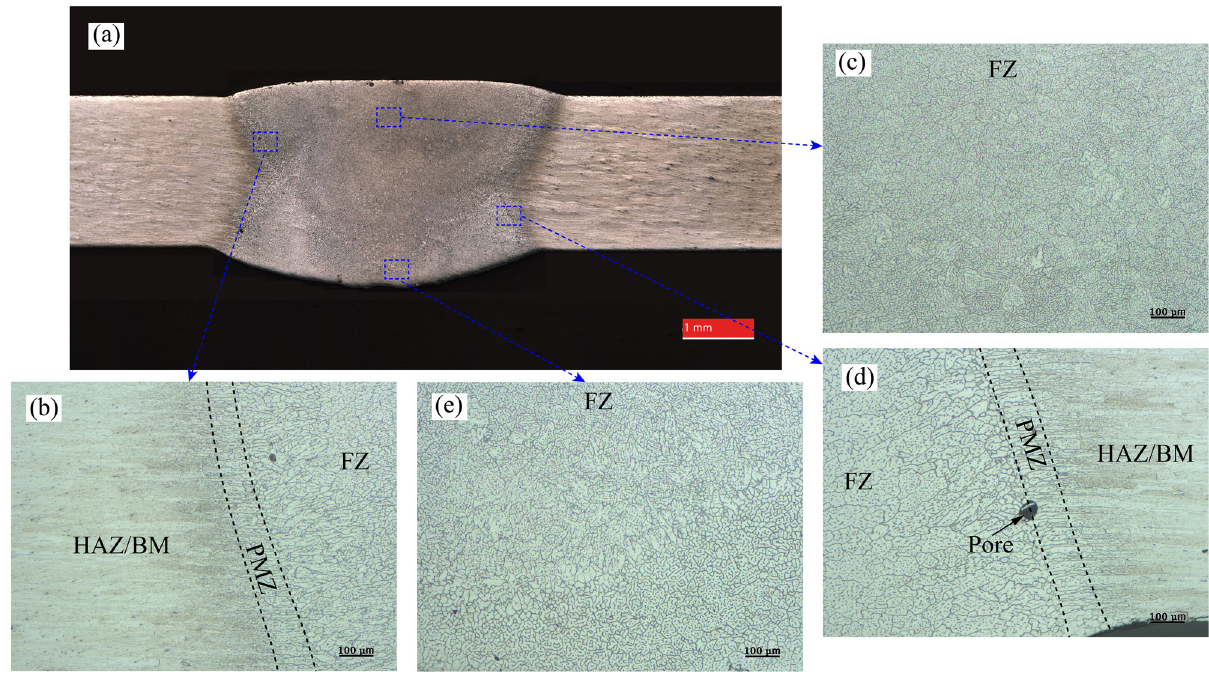
Figure 7: Case 2: metallographic